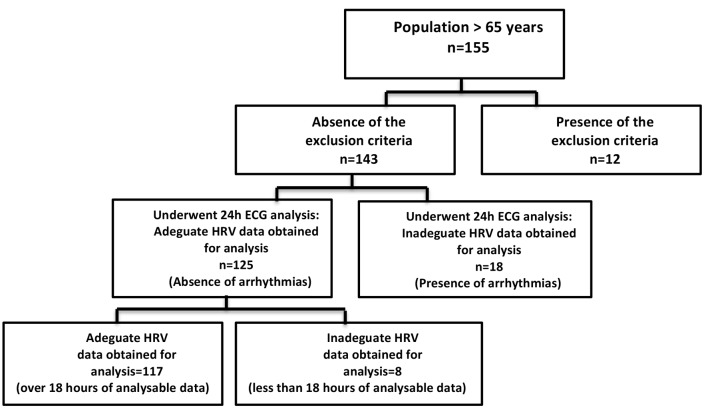
Flowchart of the study participants.